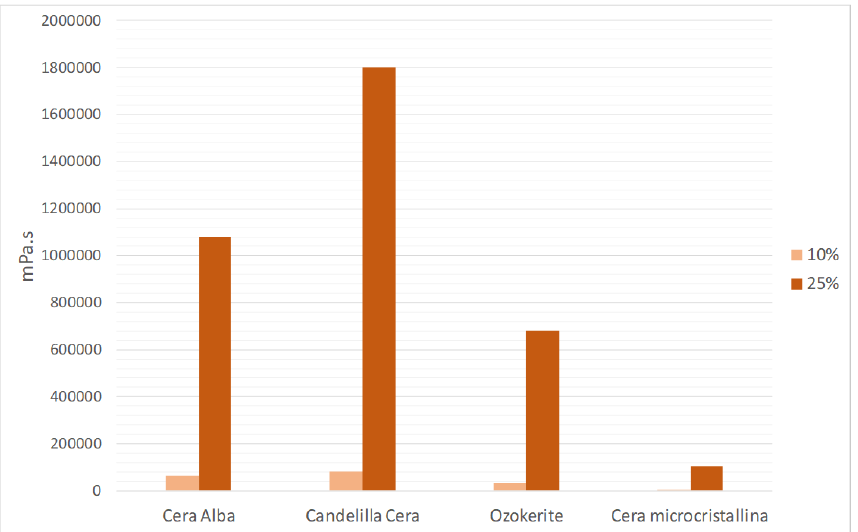
Figure 1. Viscosity values at 2.5 rpm for the most compatible waxes at 10% and 25% at T0 (at 0.5 rpm for 25% Candellila Cera).